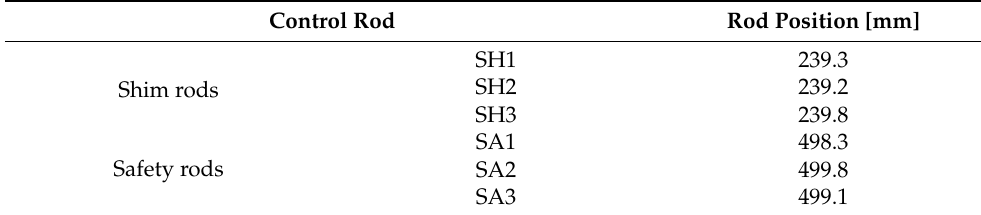
Figure 10. Positions and Void FA Loading for Void Reactivity Measurement. Table 5. Fixed Control-Rod Positions at Void Worth